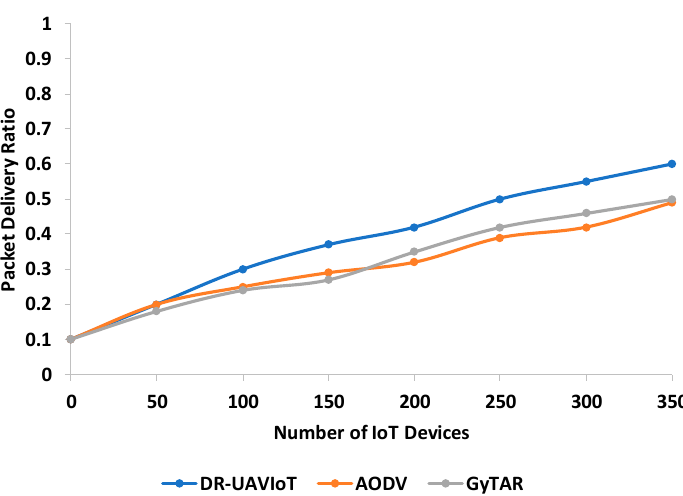
Figure 6. Packet Delivery Ratio in the Presence of Different Number of IoT Devices.